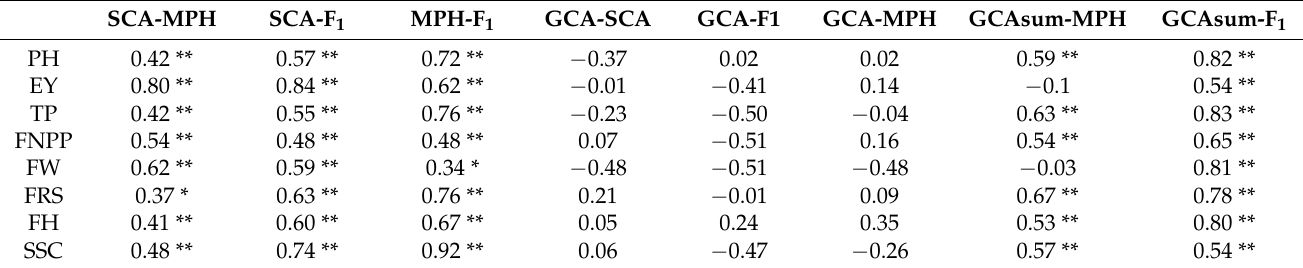
Table 7. Correlation analysis of combining ability, heterosis and F 1 phenotypic value for different traits.